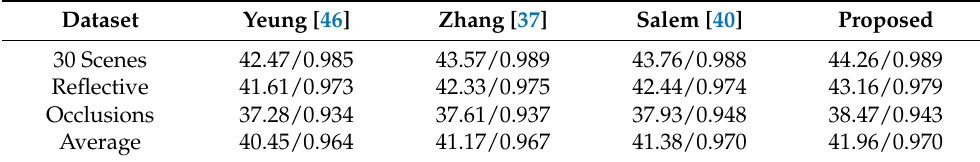
Table 3. The proposed model’s numerical comparison (PSNR/SSIM) to reconstruct 8 × 8 out of 2 × 2 views: extrapolation 1.